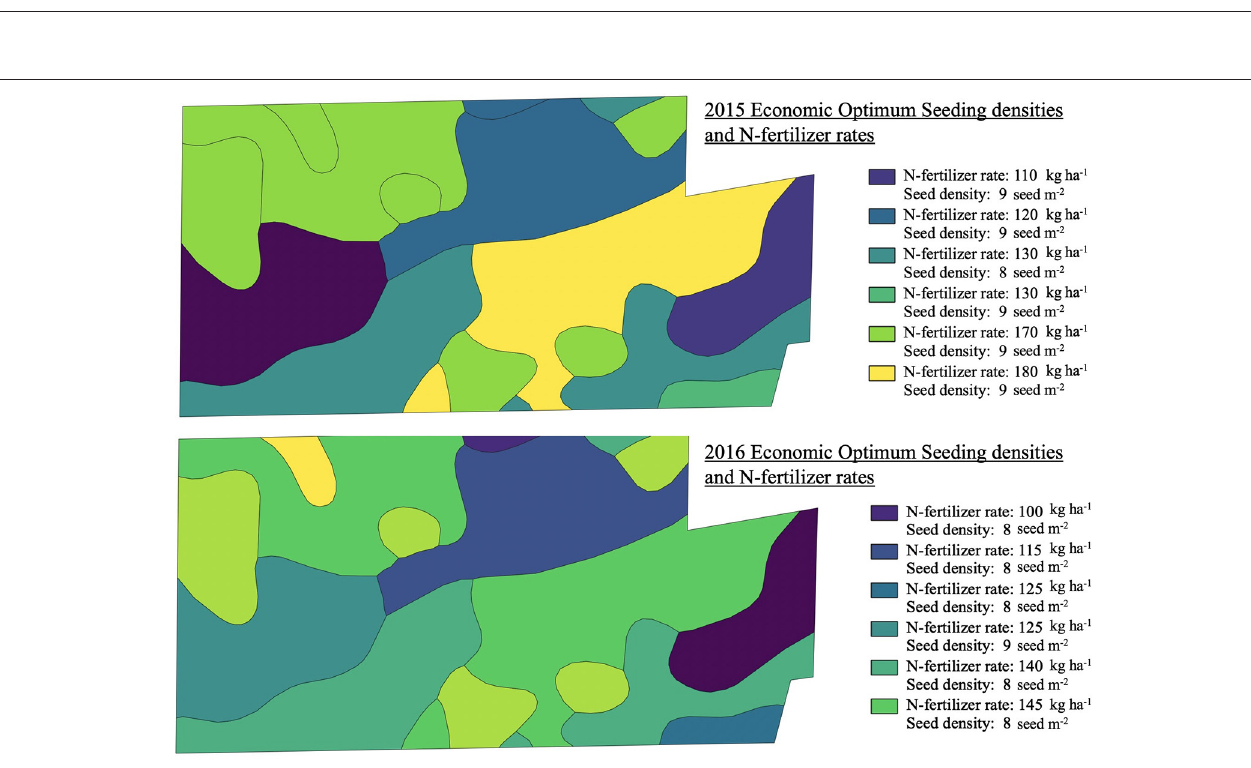
FIGURE 9 | Estimated economic optimum seeding density (EOSD) and economic optimum N-fertilizer rates (EONR) for 2015 and 2016. Management zones defined by one or more soil types sharing the same optimal combination of inputs are shown.